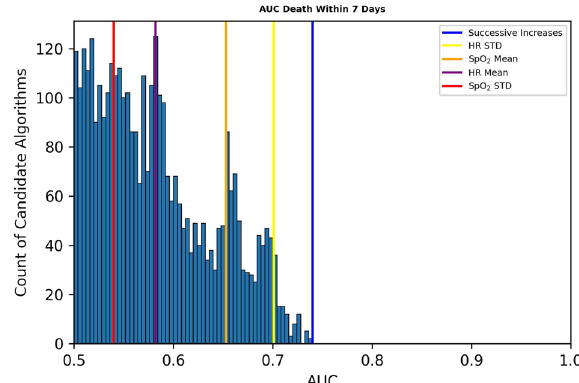
Fig. 1 AUCs of 3555 operations for predicting death in the next 7 days. Colored vertical bars from left to right indicate the AUCs of the standard deviation of oxygen saturation, mean heart rate, mean oxygen saturation, standard deviation of heart rate, and a novel measure, successive increases of heart